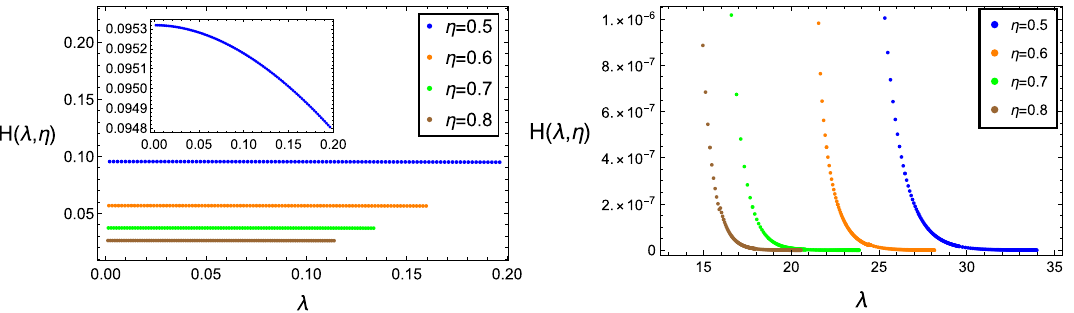
Fig. 1 The left panel shows the causal horizon entropy for z (cid:12) 1 (UV behavior), while the right panel for z (cid:13) 1 (IR behavior). The horizontal axes of both panels represent the affine parameter λ . We have set the